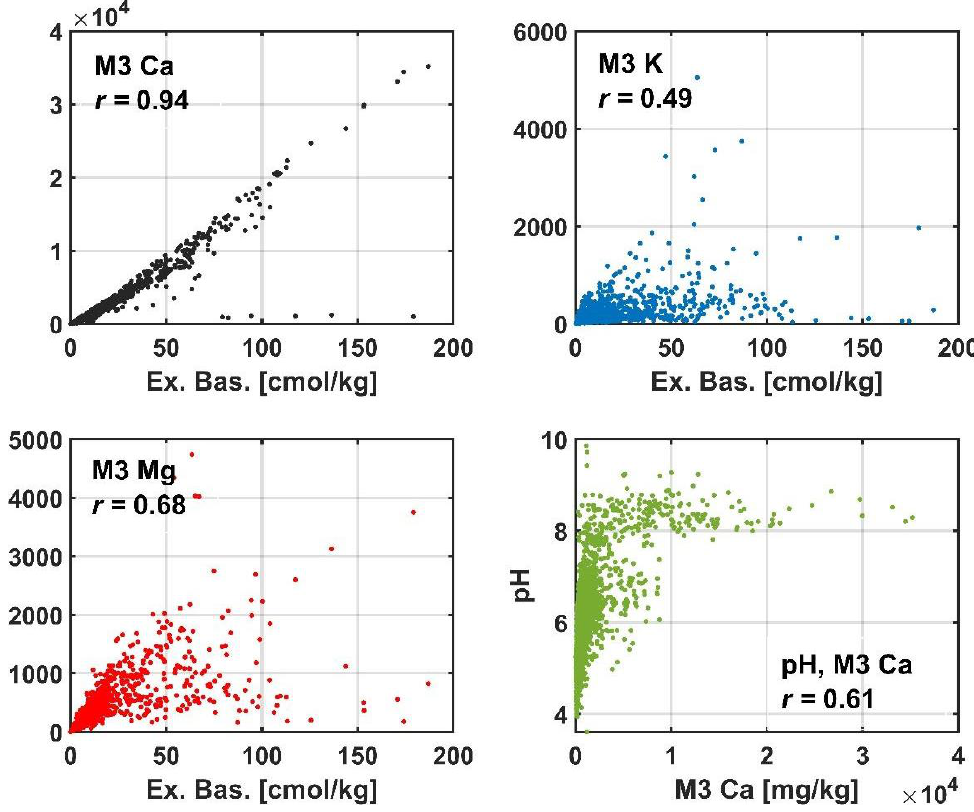
Figure 7. Scatter plots of soil variables significantly correlated with the exchangeable bases and Ca content.